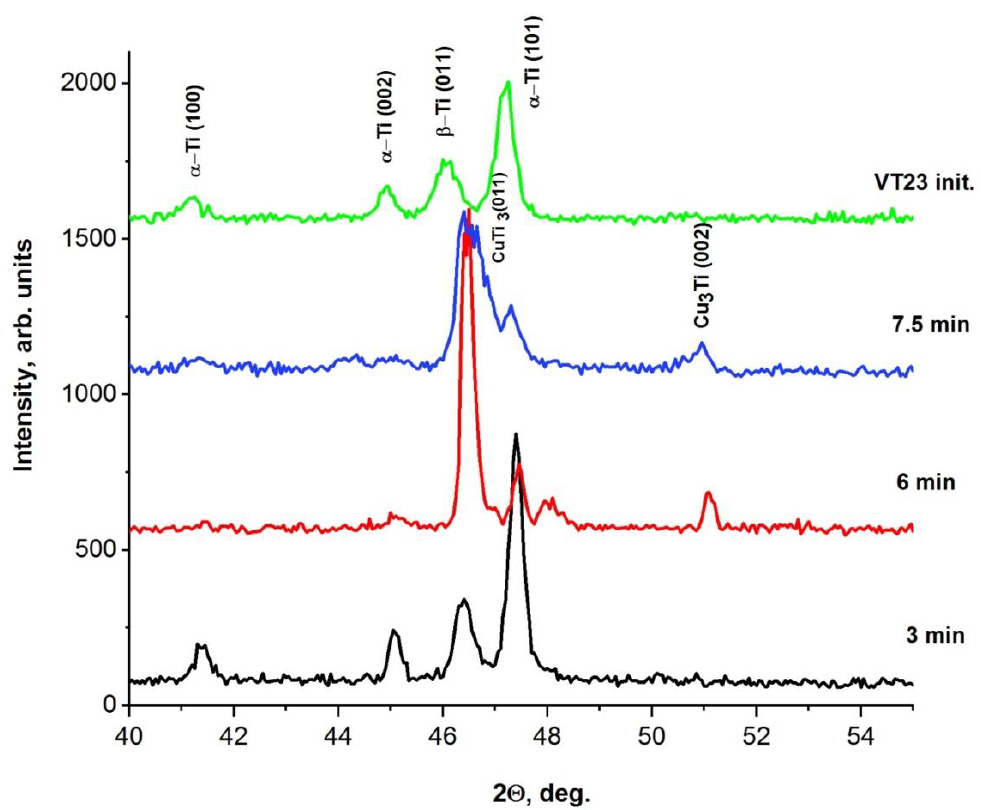
Figure 1. Fragments of the X-ray di ff raction patterns of the VT23 alloy in the initial state (1) and upon treatment with copper ions at di ff erent processing times (the processing time is indicated on the X-ray di ff raction pattern).